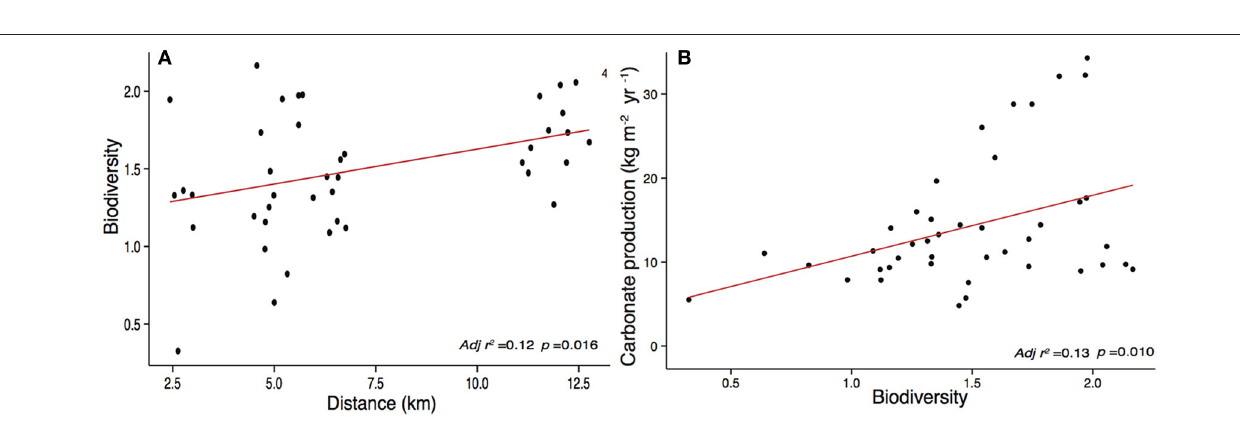
± 0.24 at 5 and 10 m, respectively) and richness ( M = 2.3